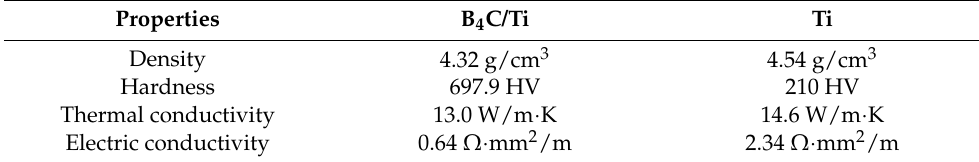
Table 2. Functional properties of B 4 C/Ti